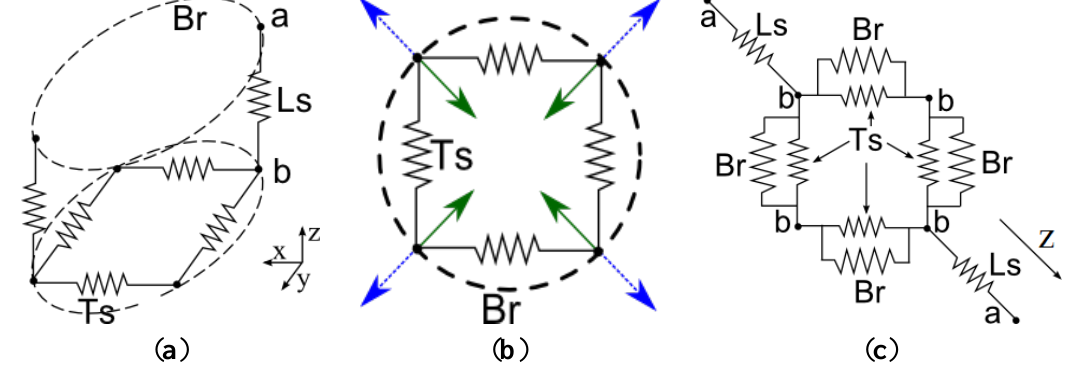
Figure 2. Schematic diagrams of the arrangement of the SMA springs composing a single unit inside the arm: ( a ) 3D representation; ( b ) transverse spring forces; ( c ) simplified planar representation of the complete system. Four transverse springs (Ts) are connected in parallel to four springs that represent the action of the braided structure (Br). Each couple of transverse springs is connected to a longitudinal one (Ls). Green arrows represent the direction of the net force generated by the transverse springs during actuation; blue dotted arrows represent the reaction force of the braided